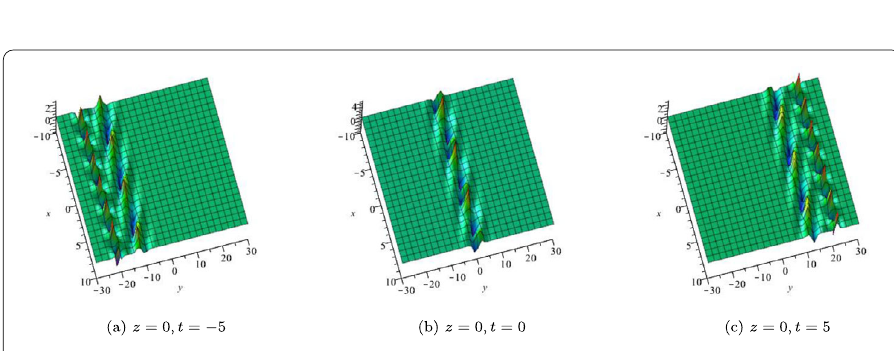
Figure 4 The interaction solutions between two general breathers of Eq. (1.2) in the ( x , y ) plane with parameters constrained by Eq.